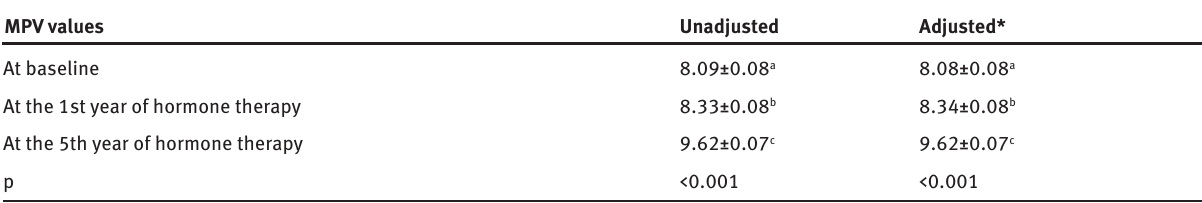
Table 3 : Change in the mean platelet volume in the patients by years